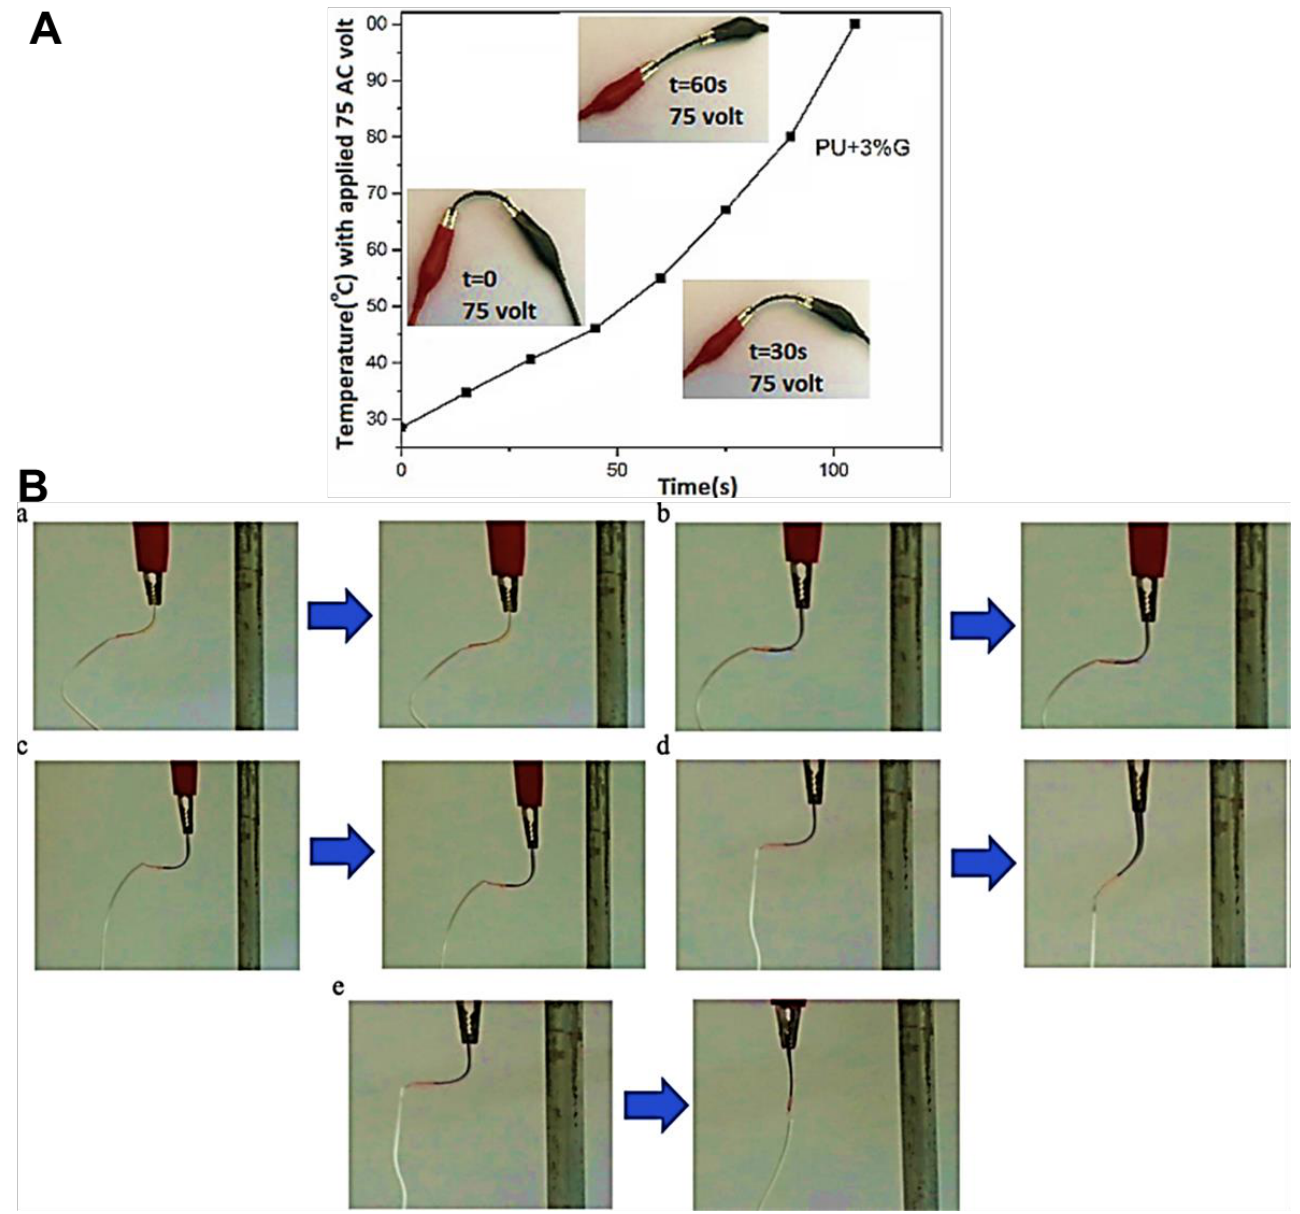
Figure 8. ( A ) Electroactuation of polyurethane/CVD graphene samples [115]. Reproduced with permission from Elsevier. ( B ) Electroactive shape memory behavior of polyurethane with 0 ( a ), 10 ( b ), 15 ( c ), 20 ( d ), and 25 ( e ) wt.% thermally reduced graphene. The as-cast straight line is deformed (left) and recovered (right) partially with 20 and almost completely with 25 wt.%, whereas 0 and 10 wt.% do not respond to the electrical current [116]. Reproduced with permission from Elsevier.